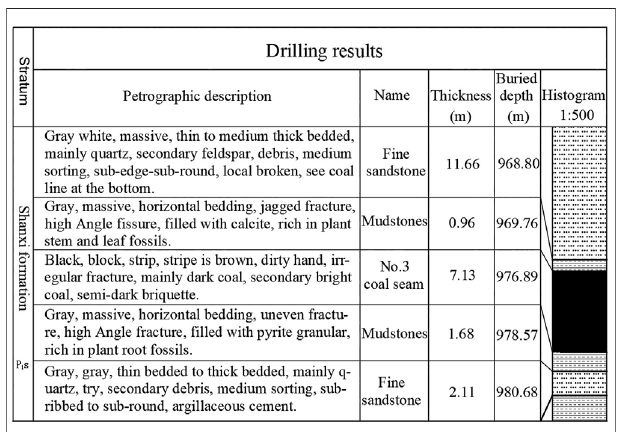
FIGURE 1 | Coal seam histogram.